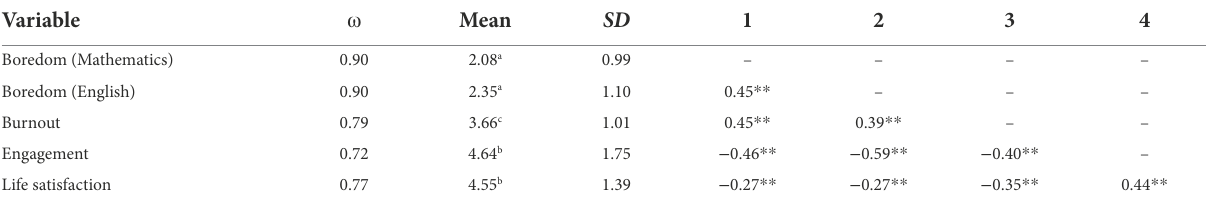
TABLE 3 Descriptive statistics, reliability coefficients, and Pearson correlations of the scales ( N = 544).